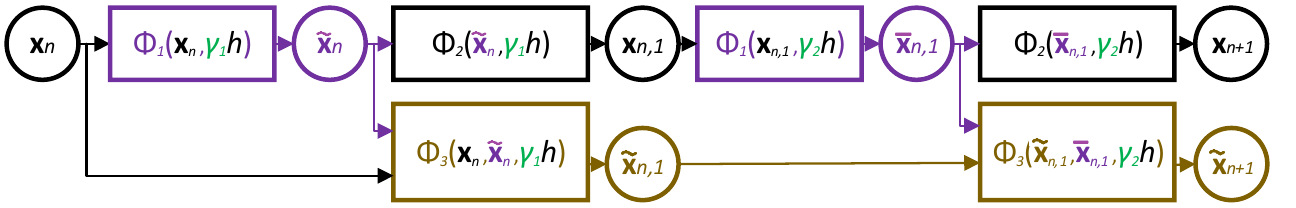
Figure 3. General scheme of proposed error estimation algorithm in 2-stage composition scheme. In Figure 3, 𝐱 𝑛 =